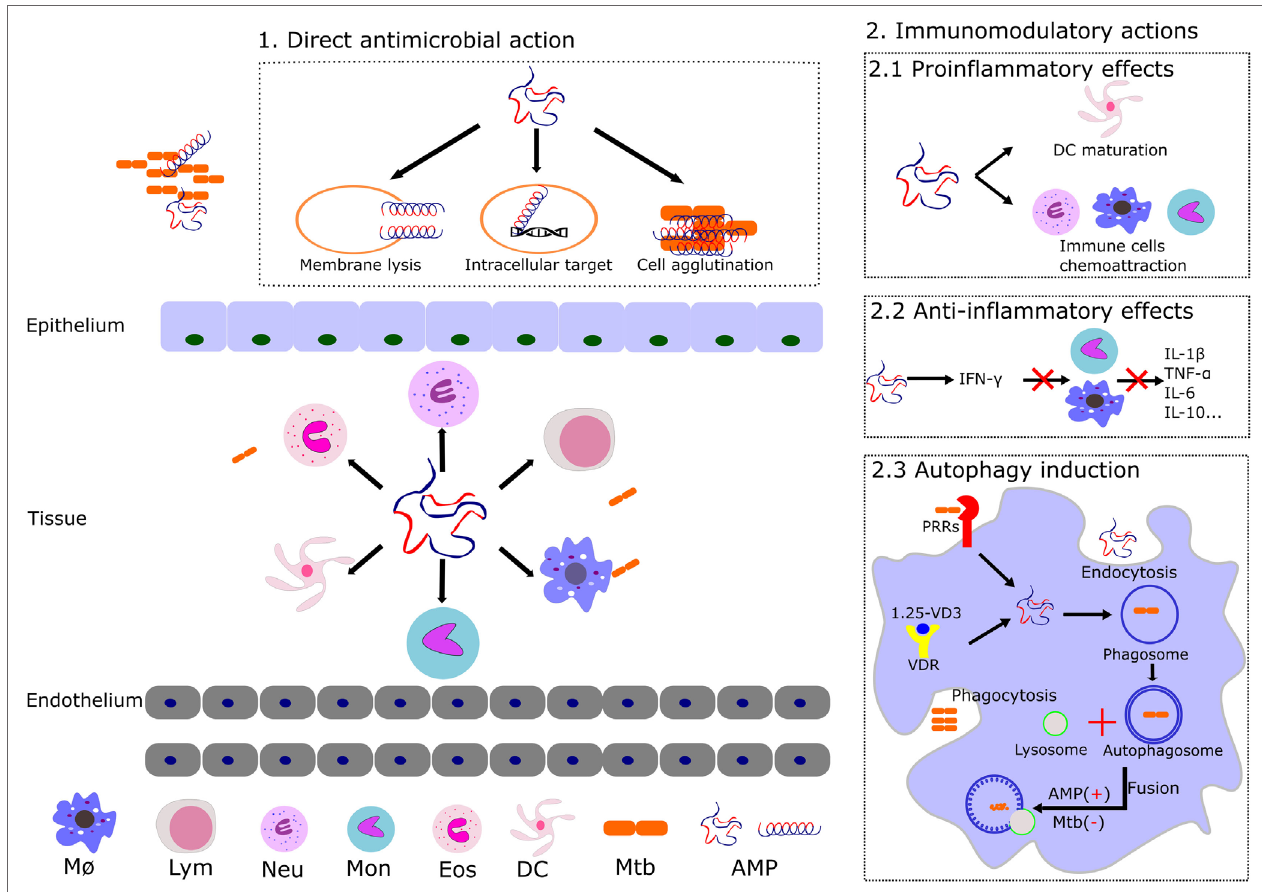
FiGURe 2 | Illustration of the distinct reported mechanism of action of AMPs expressed by the host innate immune cells. The main AMP antimicrobial and immunomodulatory activities are shown: (1) AMPs can trigger the cell lysis, target intracellular key processes (described in Figure 1 ), and/or agglutinate the bacterial cells. (2) Main AMPs’ immunomodulatory actions that promote the mycobacterial clearance are illustrated. Induction of pro and anti-inflammatory activities contributes to the host defense by regulation of cytokines and chemokines expression and induction of innate cell maturation. AMPs can also intervene in the autophagosome and phagolysosome formation during autophagy. Abbreviations : MØ, macrophages; Lym, lymphocytes; Neu, neutrophils; Mon, monocytes; Eos, eosinophils; DC, dendritic cells; Mtb, Mycobacterium tuberculosis ; AMP, antimicrobial peptides; VD3, vitamin D3; VDR, vitamin D receptor; PRRs, pattern recognition